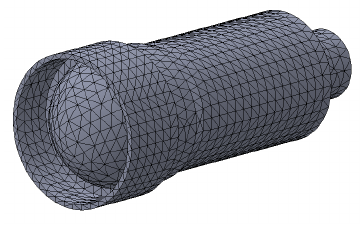
Figure 2. Meshing an ROV camera CAD model into a point cloud using SolidWorks.